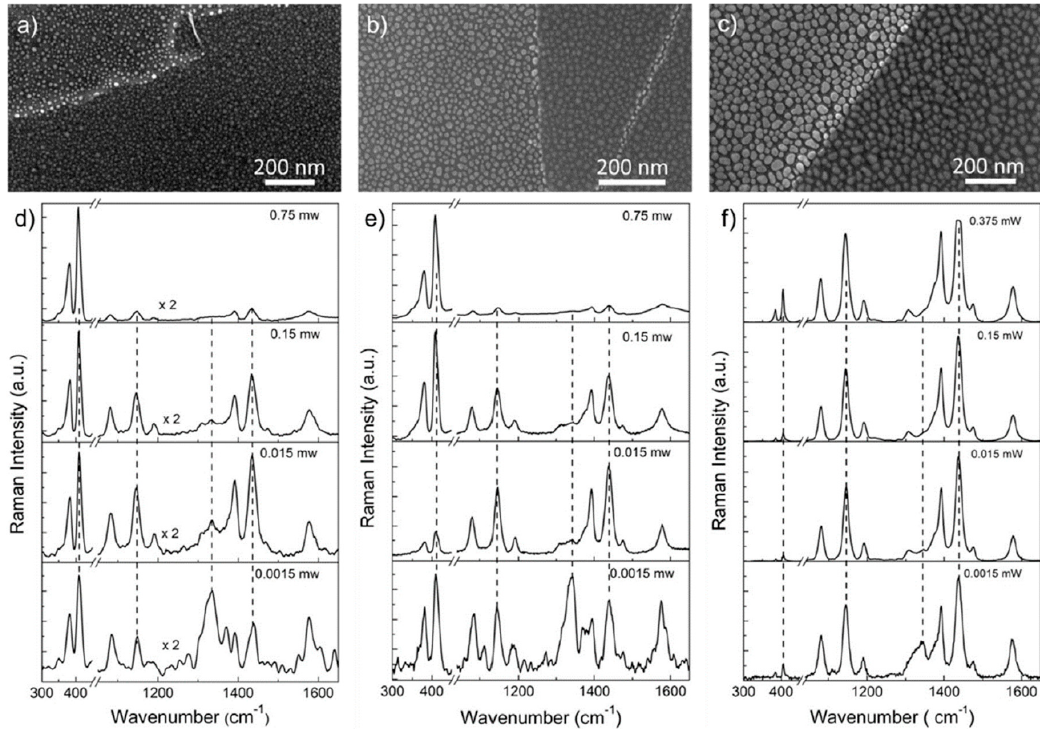
Figure 9. ( a – c ) The SEM images of MoS 2 -Ag NPs with different sizes of Ag NPs, and ( d – f ) laser power dependent SERS spectra of the MoS 2 -Ag NPs hybrids that corresponds to 9( a–c ) [111].